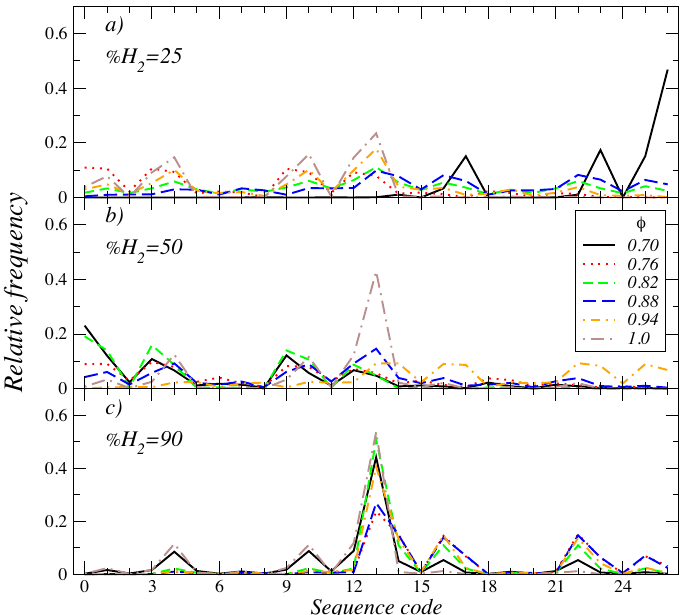
Figure 13. Symbol sequence histograms of Q r for several values of fuel–air ratio and particular hydrogen concentrations: ( a ) % H 2 = 25, ( b ) % H 2 = 50; and ( c ) % H 2 = 90. Parameters for calculations are n = 3, L = 3.